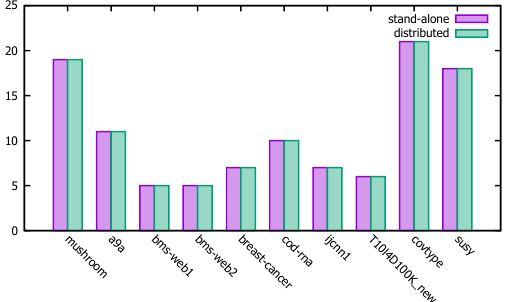
Figure 14. PFWER support for different datasets.